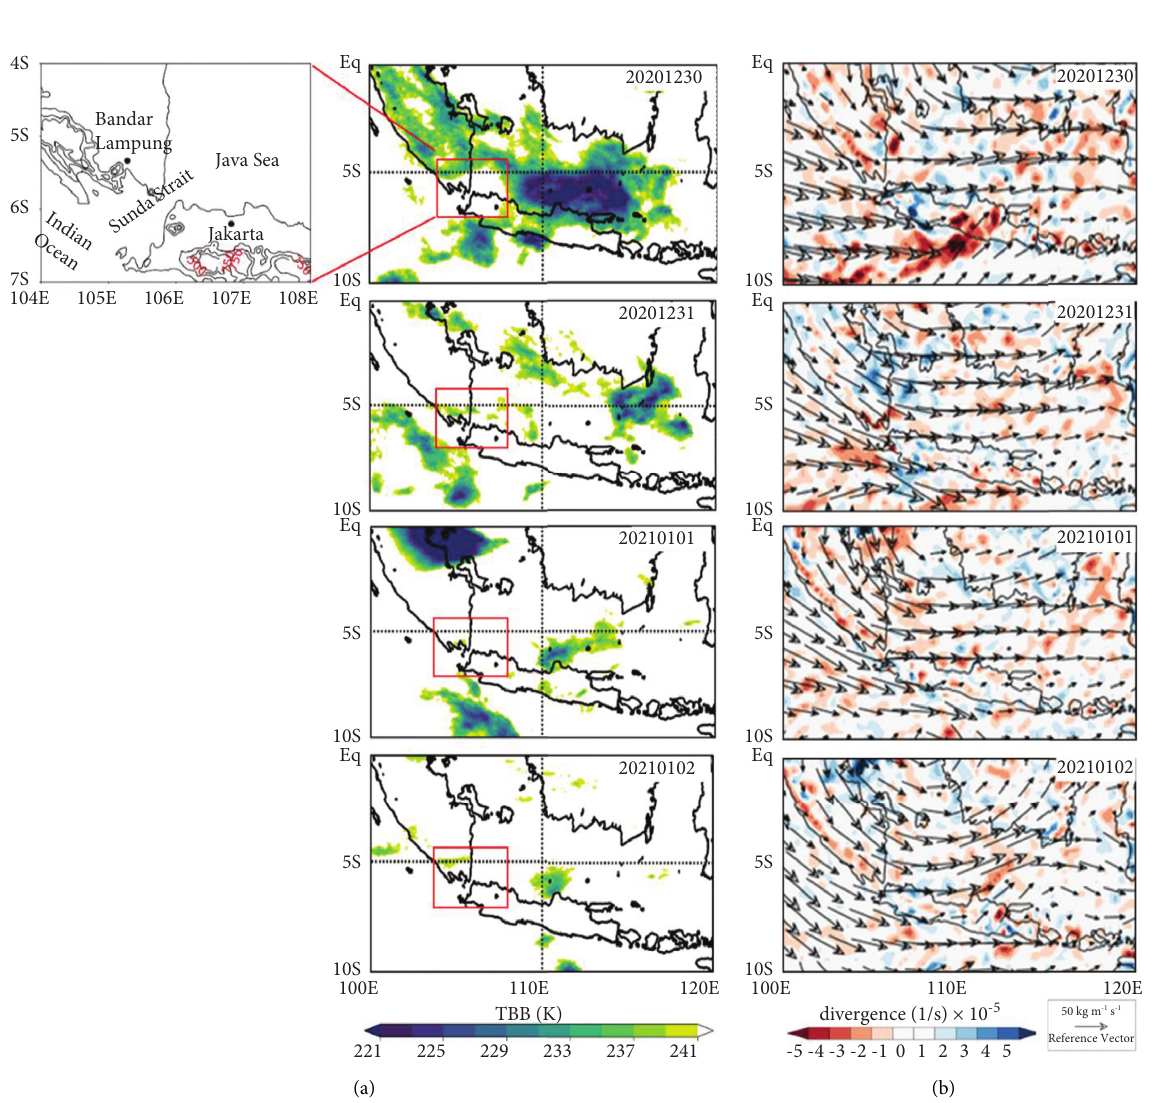
Figure 2: Time evolution from December 30, 2020, to January 2, 2021, for (a) spatial distribution of daily averaged TBB derived from IR1 Himawari satellite imageries; (b) daily averaged vertical integrated of moisture transport (vector) and divergence (shaded) plotted from the NCEP-FNL data, corresponding to the TBB map of the left panels. The area of interest is indicated by a red-square